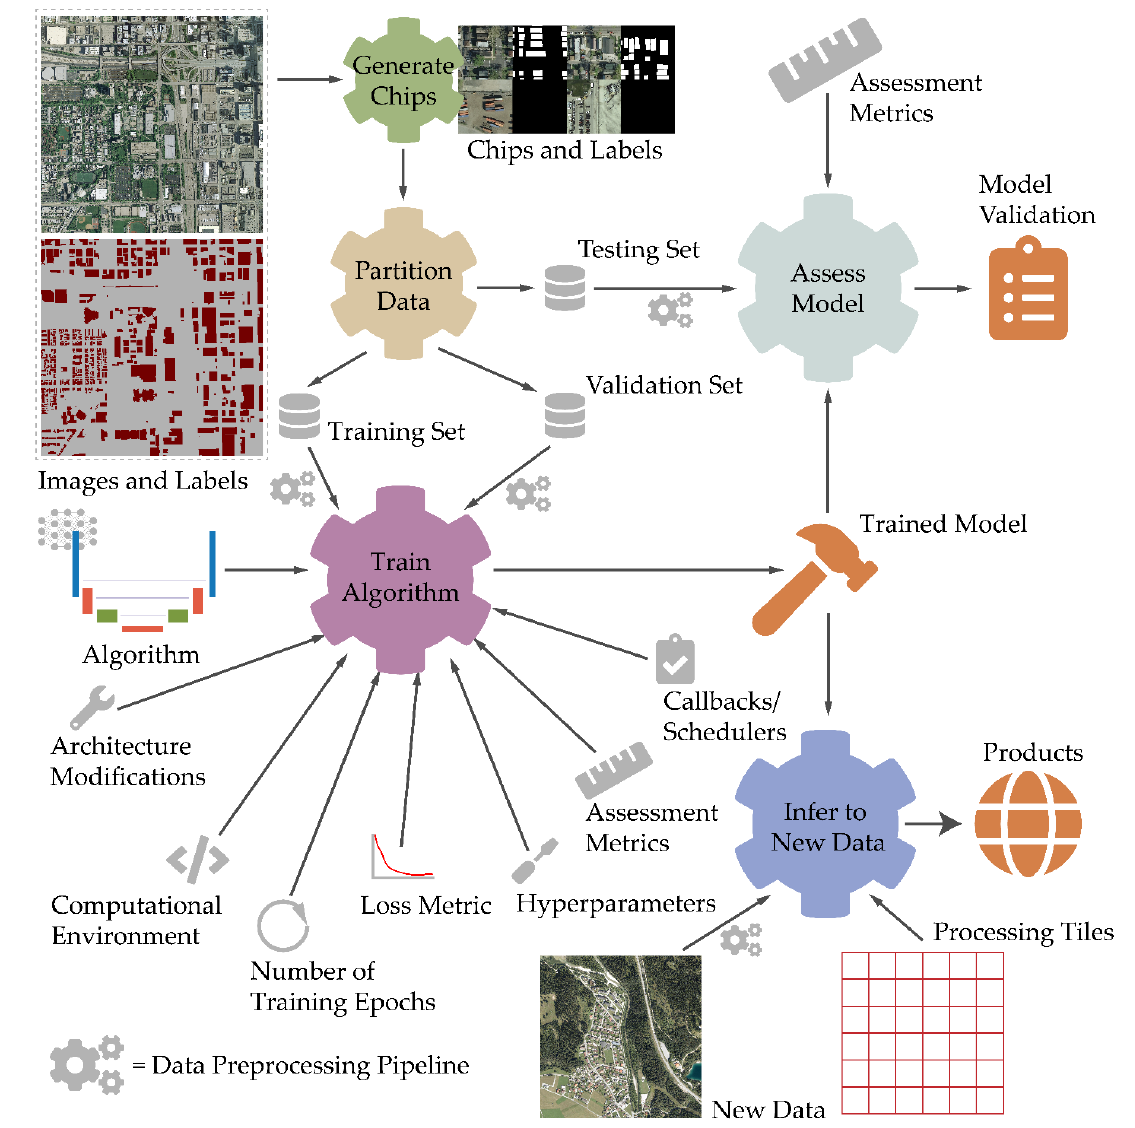
Figure 1. Conceptualization of CNN-based deep learning workflow for semantic segmentation of remotely sensed imagery highlighting user-input and customization. Icons from Font Awesome and made available under a CC by 4.0 license.